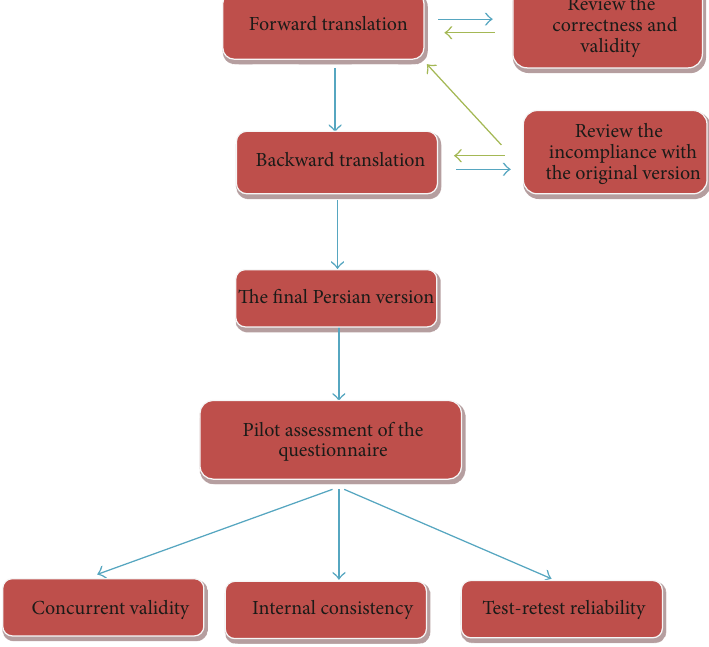
Figure 1: The development process and evaluation of the Persian version of